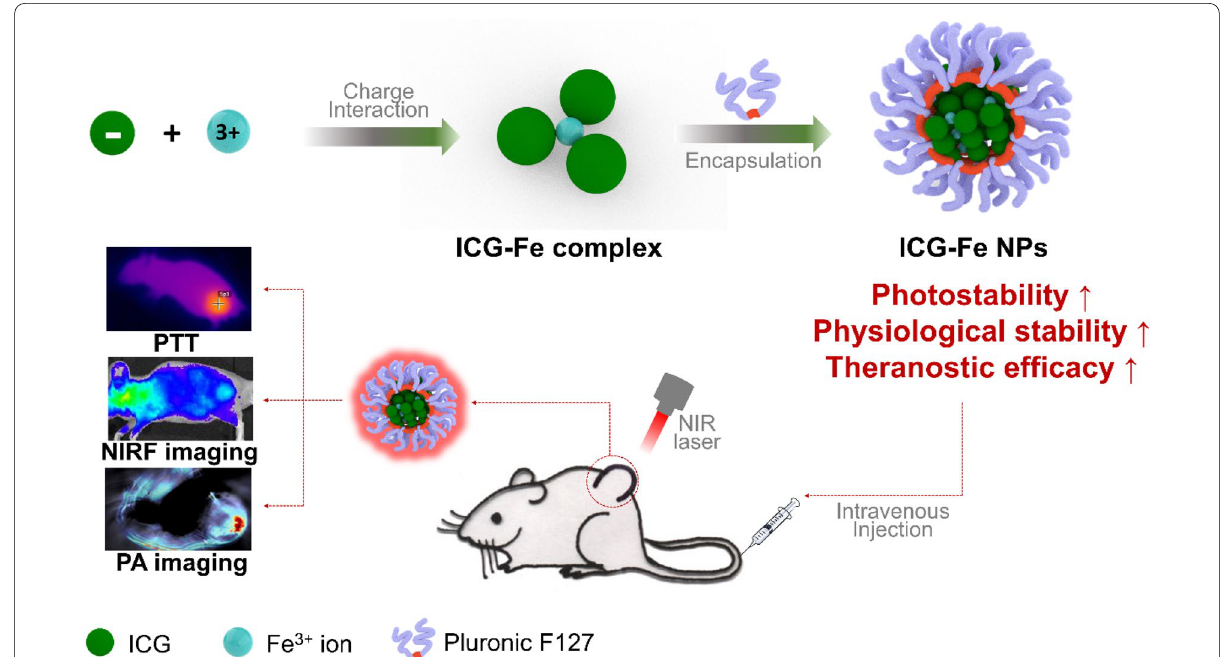
Fig. 1 Schematic illustration of ICG‑Fe NPs as theranostic nanoformulations for photonic